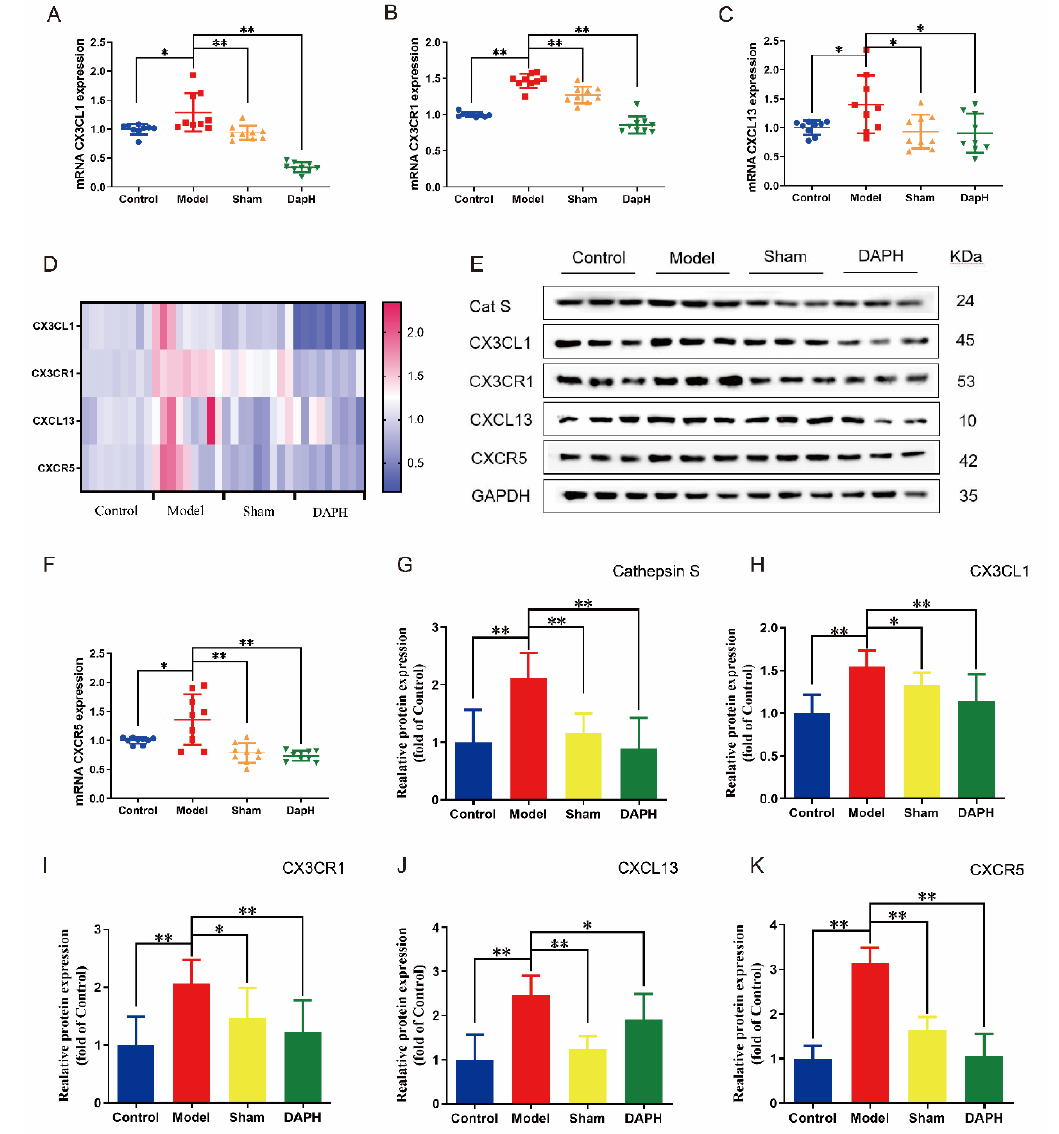
Figure 4. Effect of daphnetin on chemokines in the spinal cord of NP rats. ( A − D , F ) Expression of chemokines CX3CL1, CXC3R1, CXCL13, and CXCR5 mRNA in the spinal cord of NP rats ( n = 3). ( E ) Western blot protein bands of chemokines CX3CL1, CXC3R1, CXCL13, and CXCR5 and CatS in the spinal cord of NP rats ( n = 3). ( G − K ) Western blot protein expression of chemokines CX3CL1, CXC3R1, CXCL13, and CXCR5 and CatS in the spinal cord of NP rats ( n = 3). * p < 0.05, ** p < 0.01. The blue circles, red squares, green and yellow triangles refer to the individual data of the Control, Model, Sham and DAPH groups, respectively.